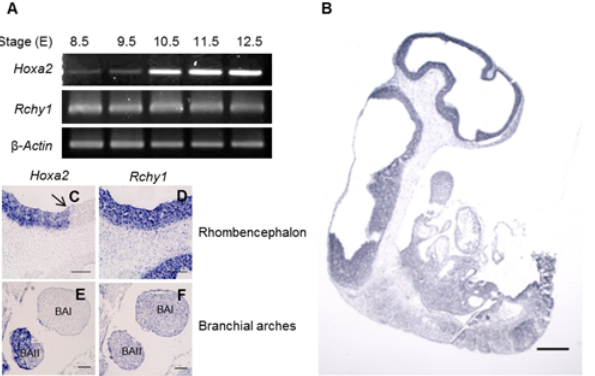
Fig 4. Rchy1 and Hoxa2 expression patterns overlap during mouse embryogenesis. (A) Detection of Hoxa2 , Rchy1 and β -Actin transcripts by RT-PCR in mouse embryos from E8.5 to E12.5. ISH of Rchy1 (B-D-F) and Hoxa2 (C-E) on sagittal cryosections of mouse embryos at E10.5. The black arrow indicates the boundary between the r1 and r2 rhombomeres. BAI; first branchial arch, BAII, second branchial arch. Scale bar = 100 μ m.